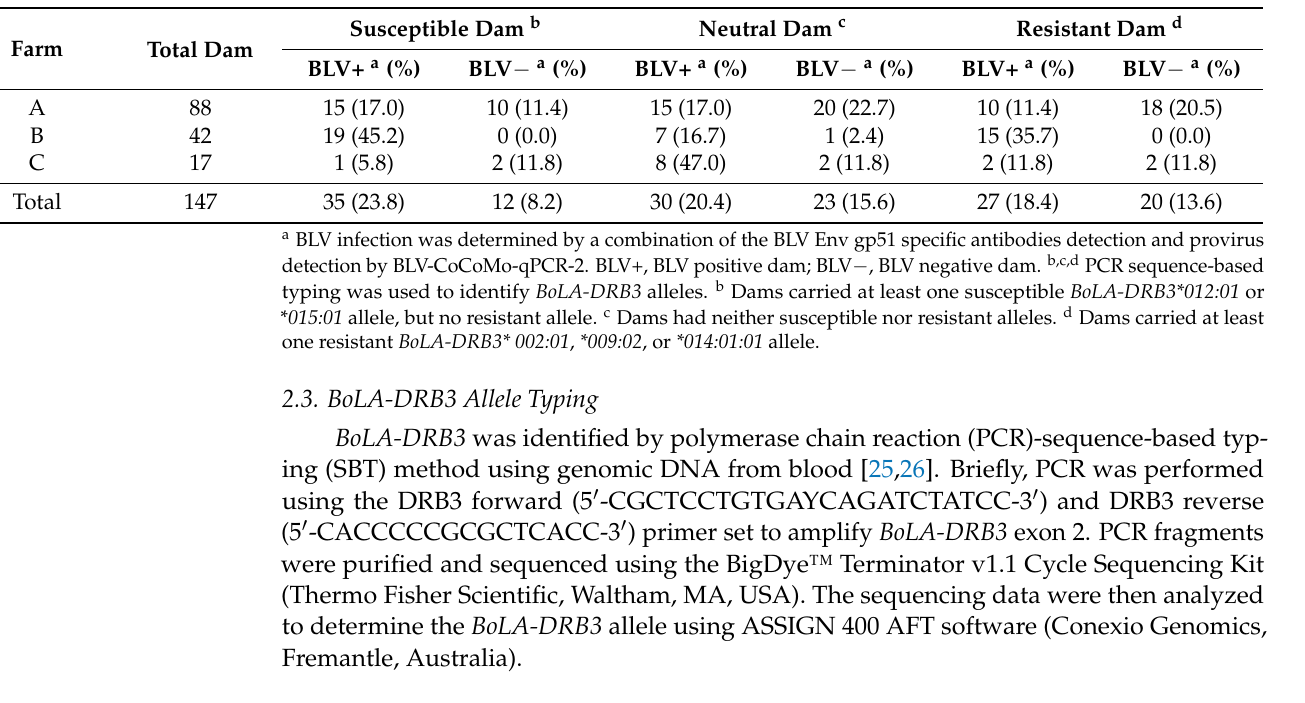
Table 1. Sample number, bovine leukemia virus (BLV) prevalence, and distribution of susceptible, neutral, and resistant